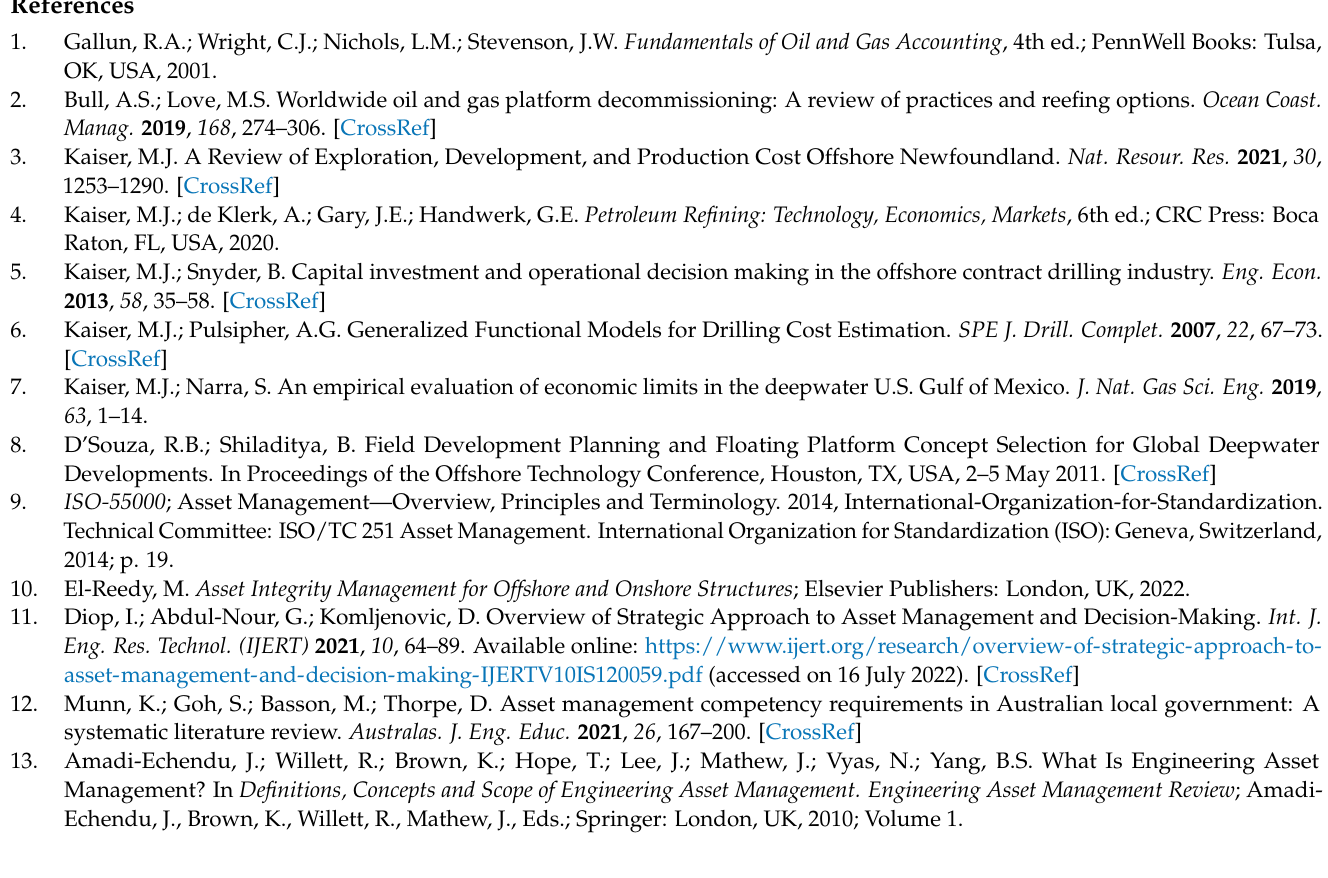
Figure A3. Map showing breakdown of projects for various assets that are located across geographical zones by an oil firm on Offshore Technology .